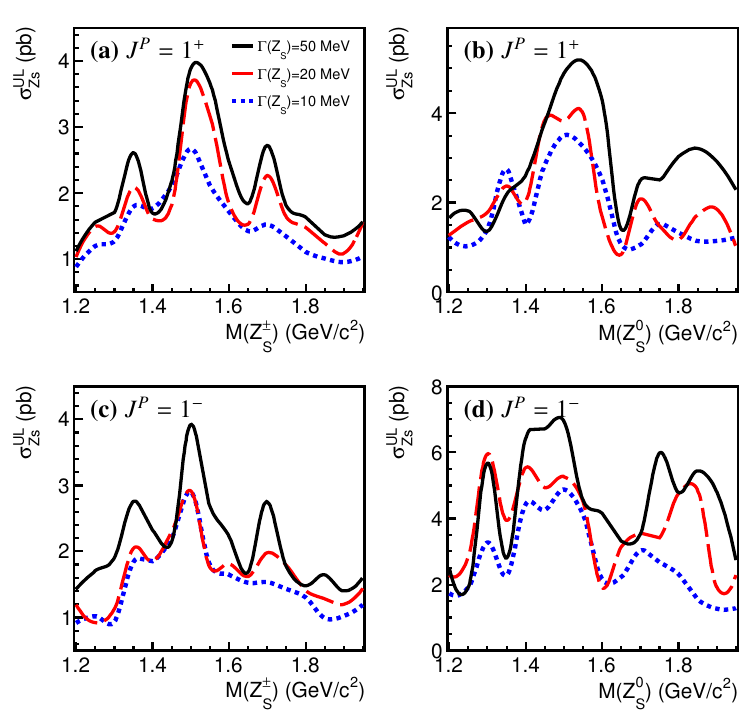
Figure 3. The upper limits at 90% C.L. on the differential cross sections of Z s as a function of assumed signal peak mass for the cases (a) J P = 1 + of Z ± of Z 0 . The dotted, dashed and solid lines are the results of Γ =10, 20, and 50 MeV, s